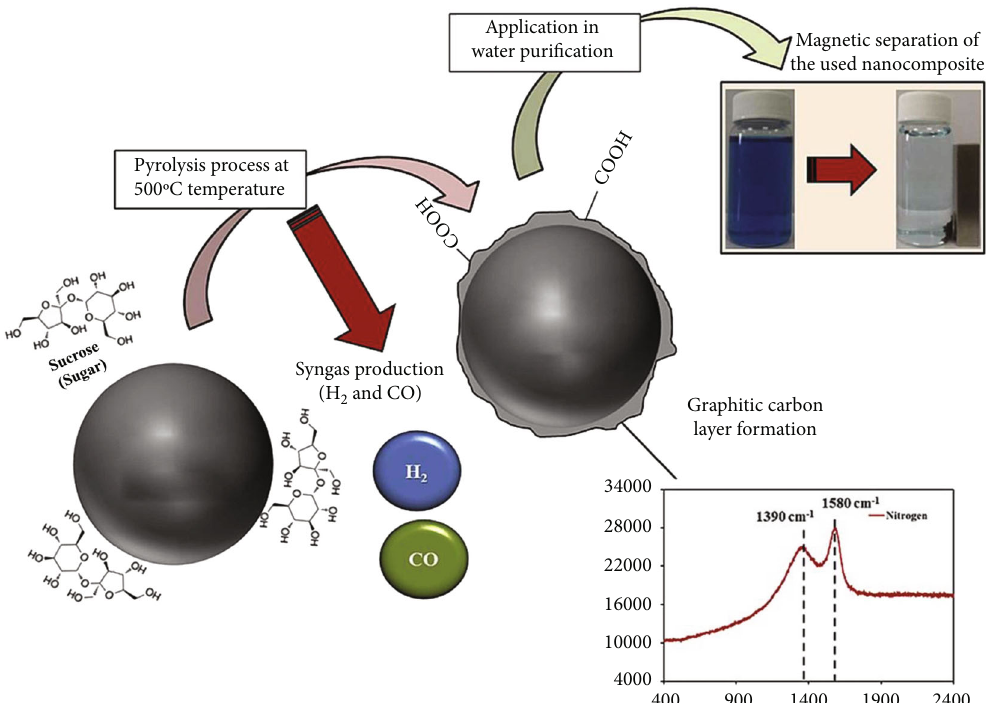
Figure 7: Preparation of novel magnetic CNC adsorbent via pyrolysis of sugar for methylene blue adsorption in aqueous solutions